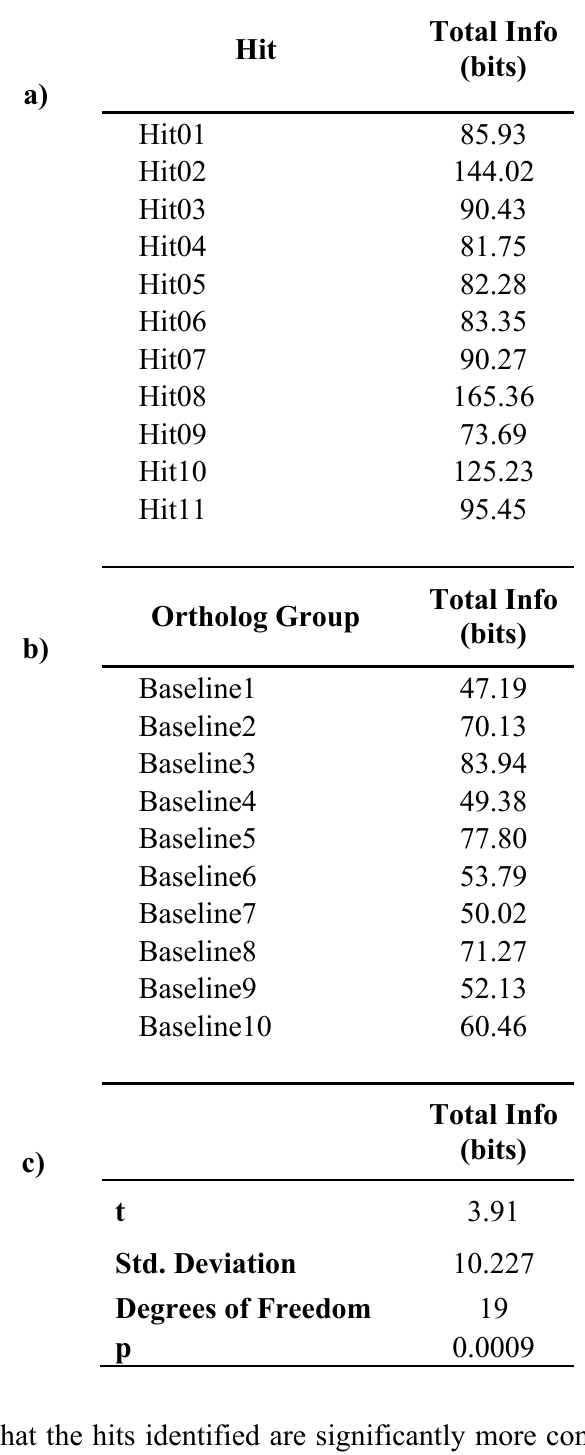
Table 4. Conservation scores calculated for (a) hits and (b) baseline sequences. Section (c) compares averages for the hits versus those for the baseline